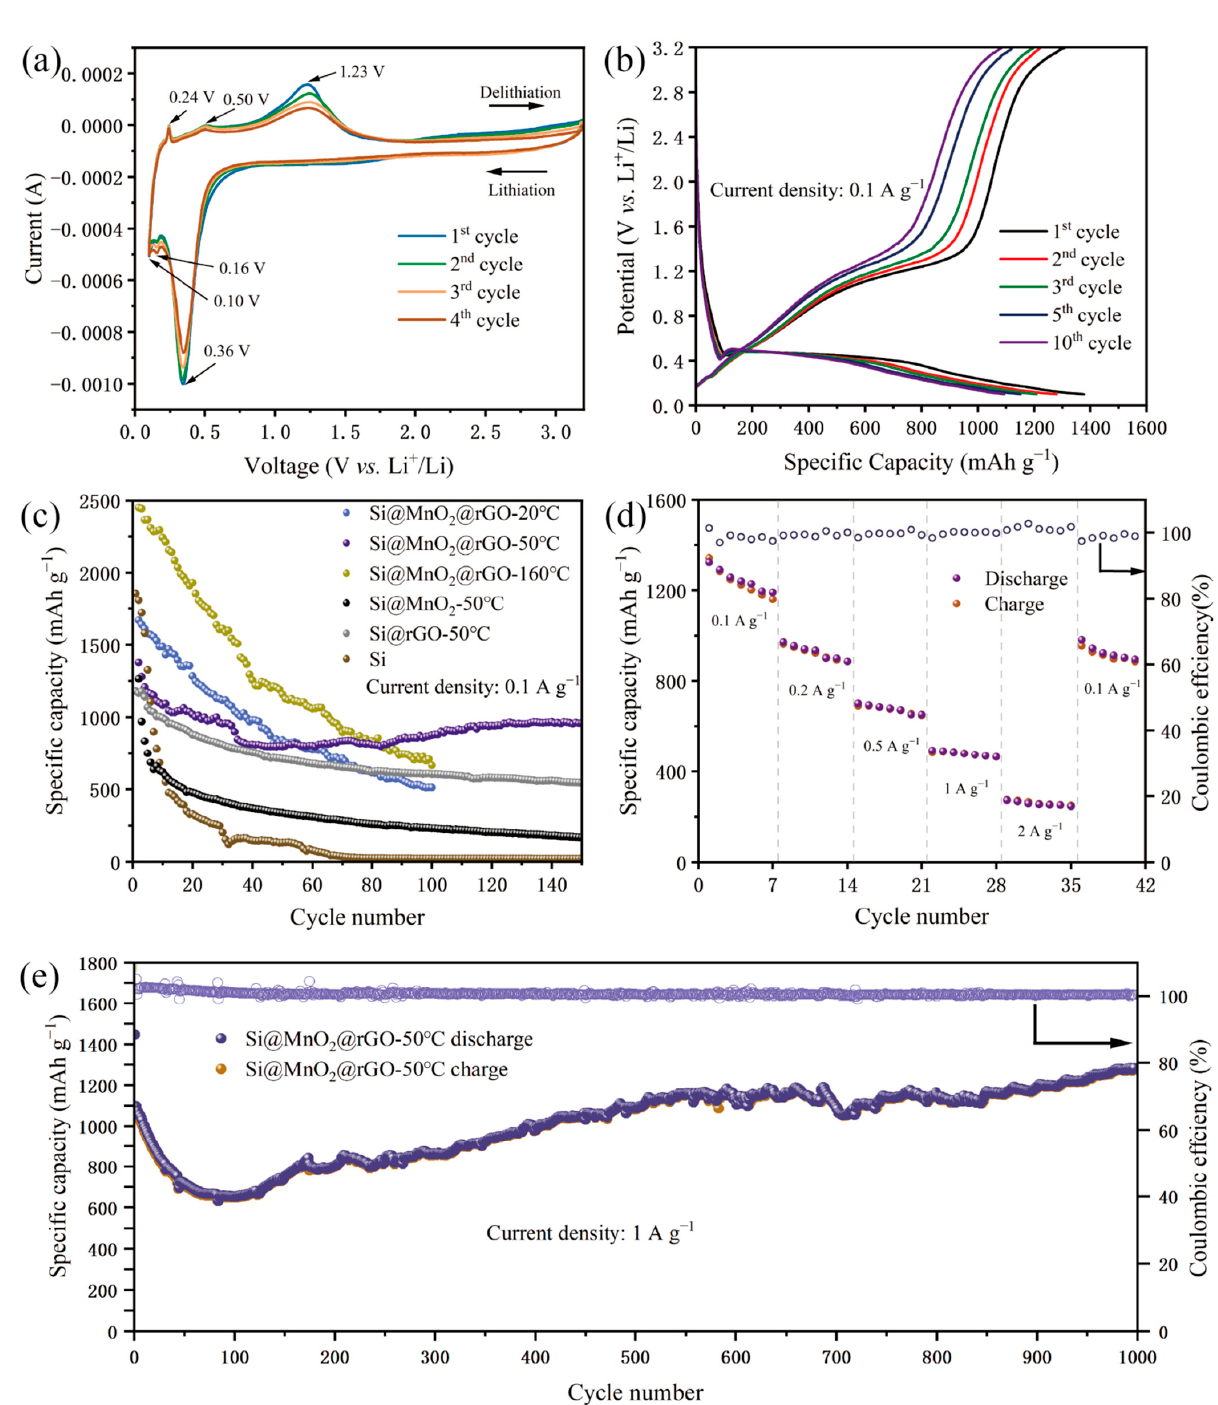
Figure 5. ( a ) CV curves of the Si@MnO 2 @rGO-50 ◦ C at 0.1 mV s − 1 between 0.1 V and 3.2 V. ( b ) Gal- vanostatic charge–discharge curves of the Si@MnO 2 @rGO-50 ◦ C at 0.1 A g − 1 . ( c ) Long-term cycling performance of the Si, Si@MnO 2 -50 ◦ C, Si@rGO-50 ◦ C, Si@MnO 2 @rGO-20 ◦ C, Si@MnO 2 @rGO-50 ◦ C, and Si@MnO 2 @rGO-160 ◦ C at 0.1 A g − 1 . ( d ) Rate performance of the Si@MnO 2 @rGO-50 ◦ C. ( e ) Long- term cycling performance of the Si@MnO 2 @rGO-50 ◦ C at 1 A g − 1 . EIS measurements were carried out to further investigate the electrochemical mech- The redox peaks of Si coincided with those reported previously [43–45]. In addition, anism shown in Figure 6. Figure 6a shows the EIS plots and corresponding fitting plots of the reversible redox peaks at 1.23 and 0.36 V, respectively, were consistent with the lithiation and delithiation reactions of MnO 2, according to Equation (3). When the cathodic peak was 0.36 V, Li was inserted into the anode to form LiO 2 and MnO 2 was reduced to Mn.